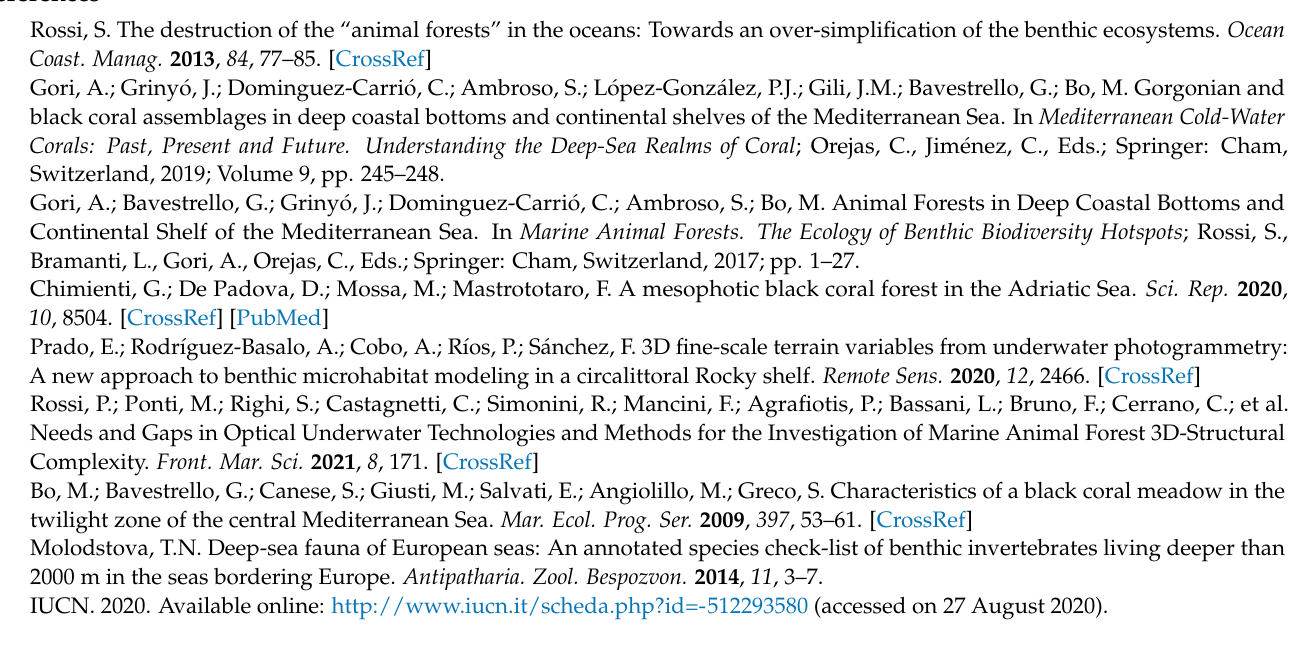
Table S3: List of species recorded within the investigated sites, Supplementary Material File S2: Table with values of the 12 metrics and their conversion in